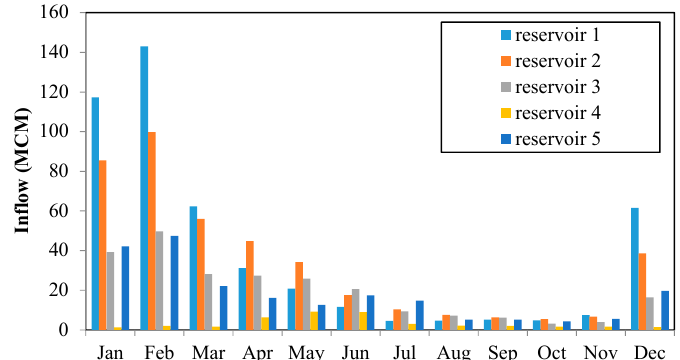
Figure 4. The average monthly inflows in million cubic meter (MCM).